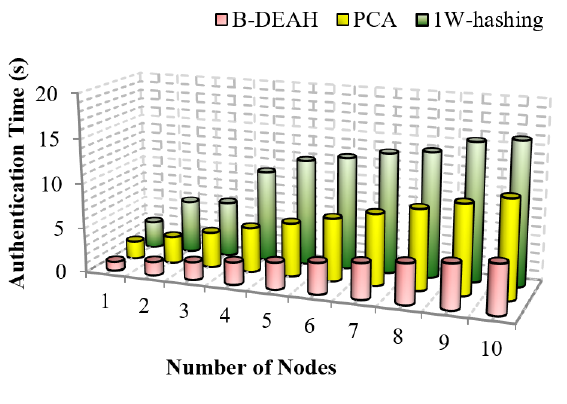
Figure 13. Authentication time vs. number of